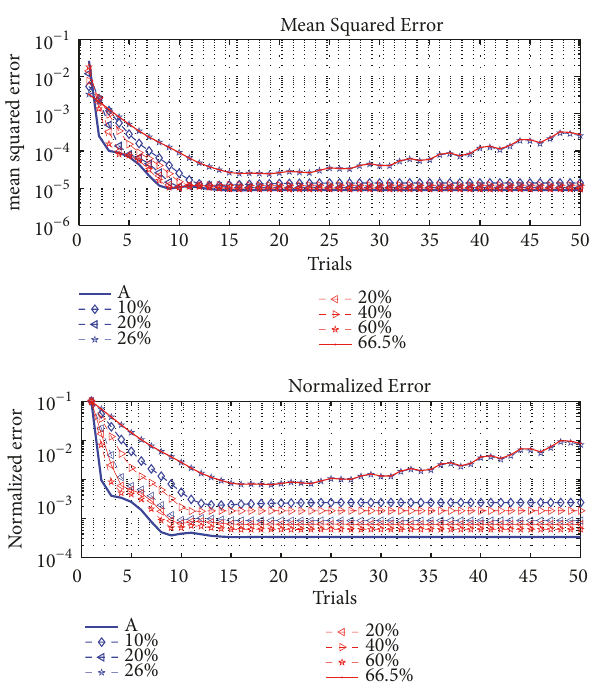
Figure 5: Theoutput signal forthe 𝑥 -axisin two different cases, with and without 𝑤.𝑓.